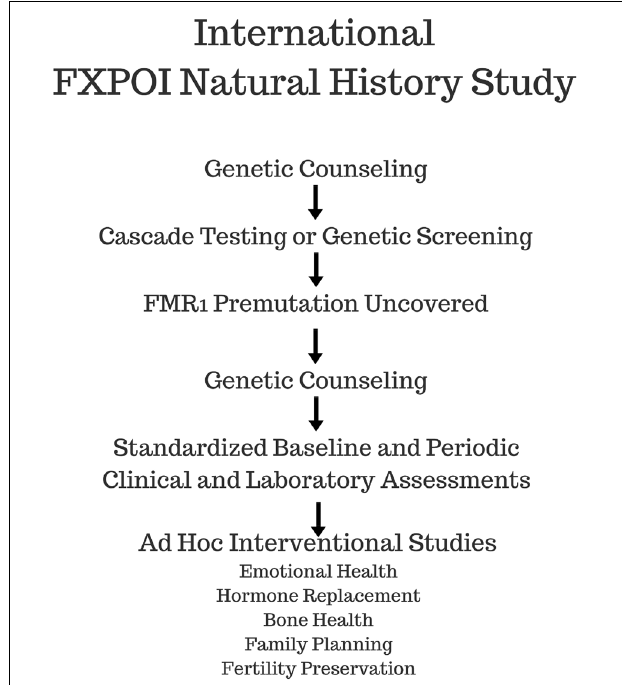
FIGURE 4 | Schematic flow diagram depicts the process to be followed by the proposed International FXPOI Natural History Study.